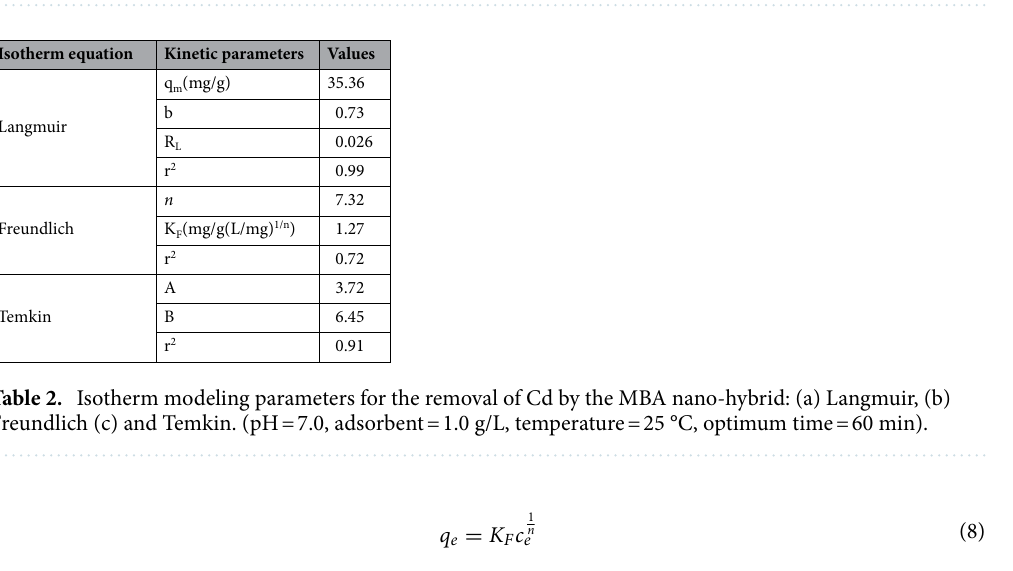
Figure 10. Adsorption isotherms for the removal of Cd by the MBA nano-hybrid: ( a ) Langmuir, ( b ) Freundlich and ( c ) Temkin (pH = 7.0, adsorbent = 1.0 g/L, temperature = 25 °C, optimum time = 60 min).